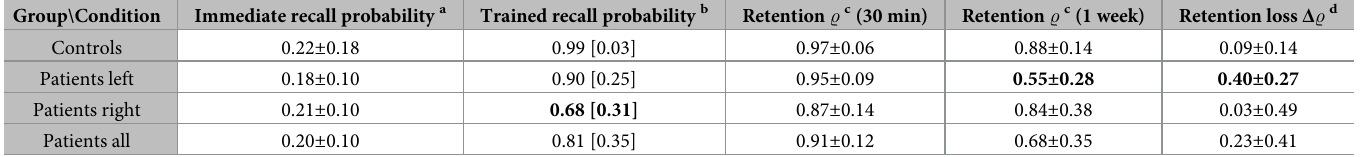
Table 2. Performance summary of memory acquisition and retention in